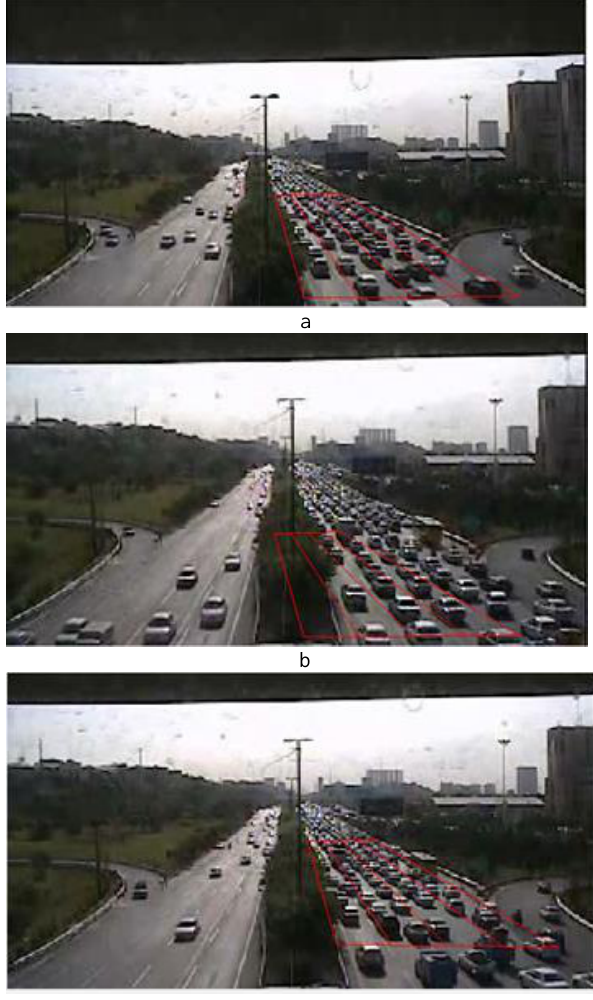
Figure 10: the results of camera position restoring. a) Initial image. b) Unadjusted image. c) Restored